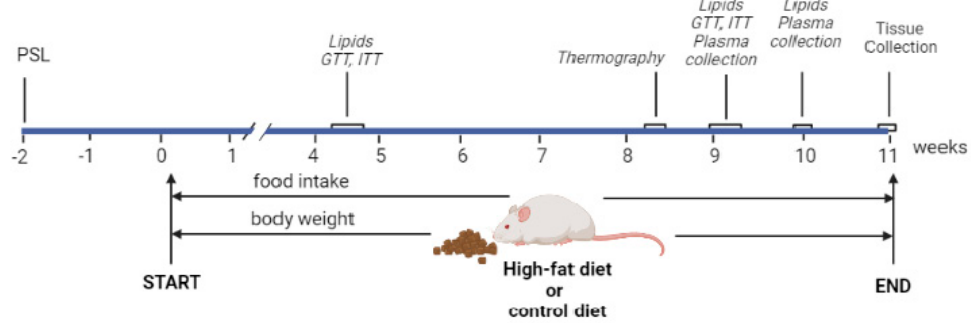
Figure 10. A scheme illustrating the experimental design and the timing of the analyses. Two weeks before the start of the experiment, the high-5HT and low-5HT animals were divided in two groups (N = 9 per group) and subjected to blood sampling for verification of platelet serotonin levels (PSL). Controlled feeding began when the animals were 2.5 months old and continued for the next 11 weeks with food intake and body weight monitored twice a week. All animals underwent blood glucose tolerance test (GTT), insulin tolerance test (ITT), blood sampling, and thermography at the indicated time points. At the end of the experiment, the animals were sacrificed, the organs were weighed, and tissue samples taken for further analysis. Created with Biorender.